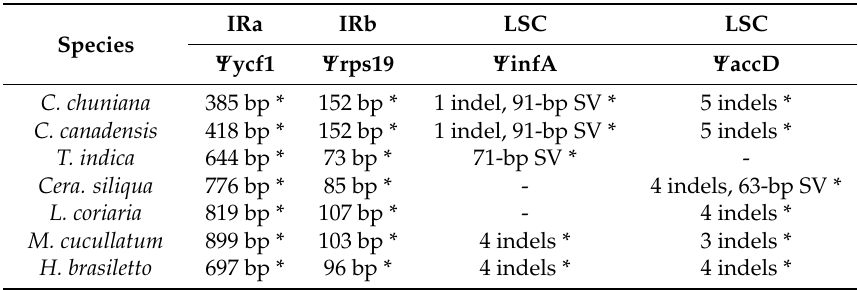
Table 2. The location and characteristics of the four pseudogenes in the seven species of caesalpinioid legumes compared in this